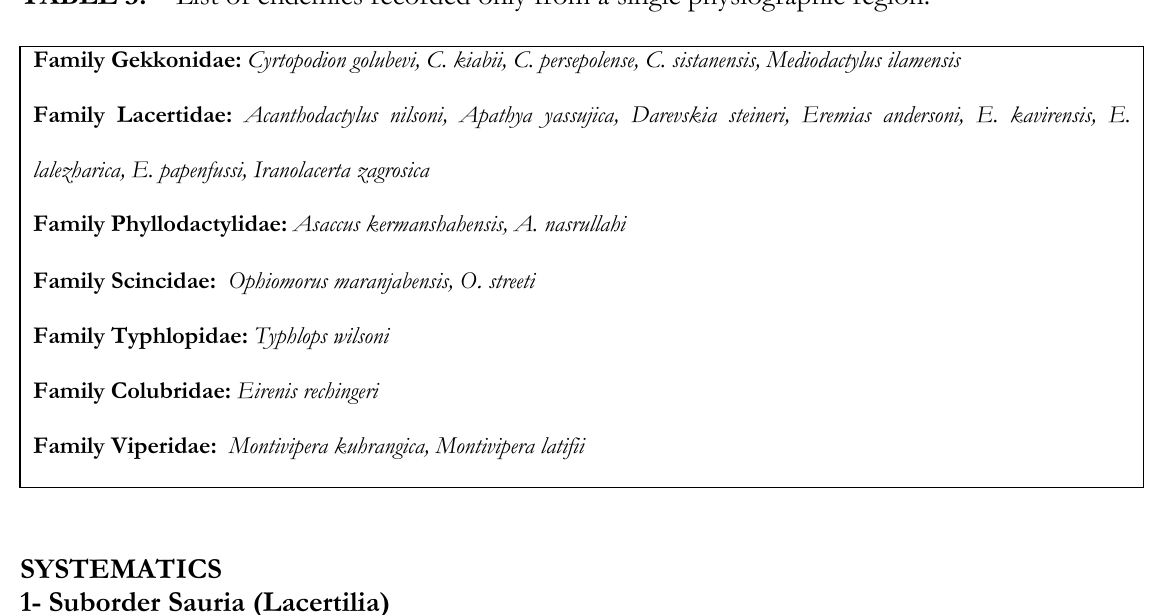
TABLE 3. – List of endemics recorded only from a single physiographic